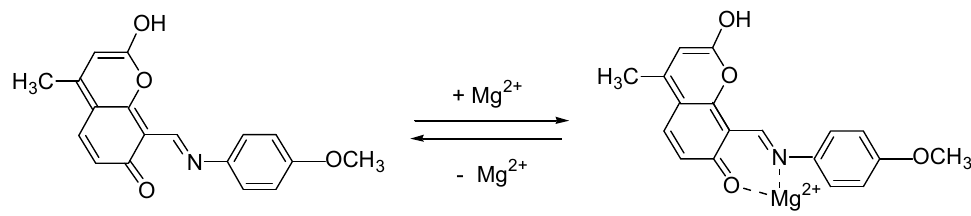
Table 2. Spectral characteristics of compound 1 and its complexes with metal ions in the mixed solvent solution at the ratio of molar concentrations of compound 1 and metal ion = 1: 100.